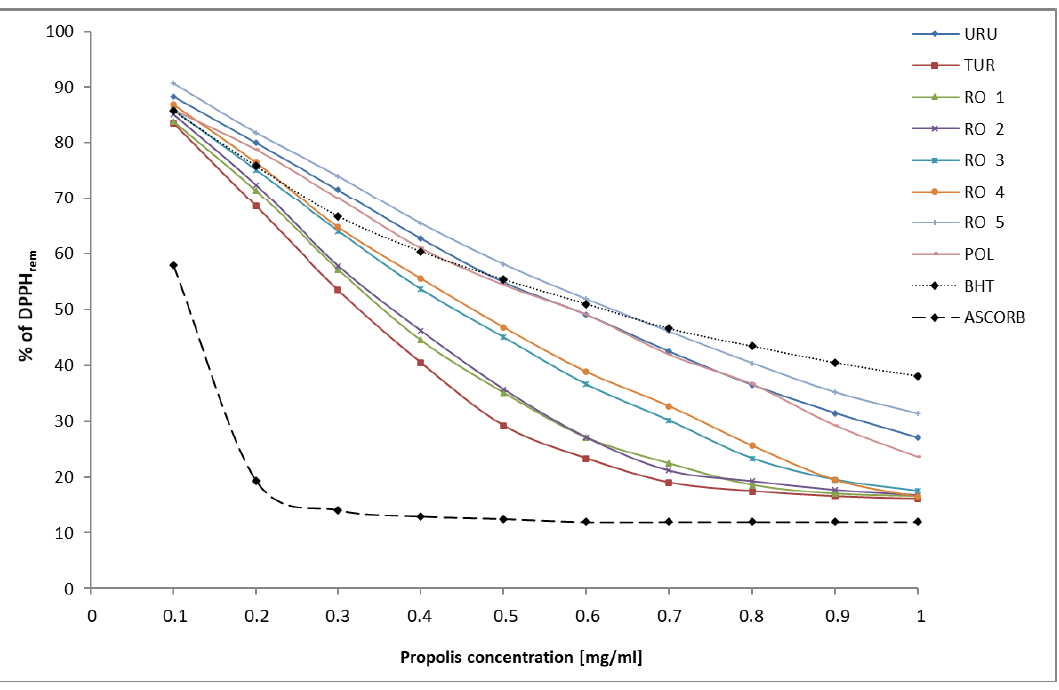
Figure 1. Percentage of remaining DPPH radical at different propolis samples (URU — Uruguayan, TUR — Turkish, POL — Polish, RO 1 – 5 — Romanian) and known antioxidants such as: butylhydroxytoluene (BHT) and ascorbic acid (ASCORB). The standard deviation (SD) of the three independent determinations of each concentration of each propolis samples has not exceeded the values as follows: URU ± 4.7, TUR ± 3.0, POL ± 3.4, RO1 ± 7.0, RO2 ± 3.1, RO3 ± 5.6, RO4 ± 4.8, RO5 ± 4.4. Points on graphs represent the average.